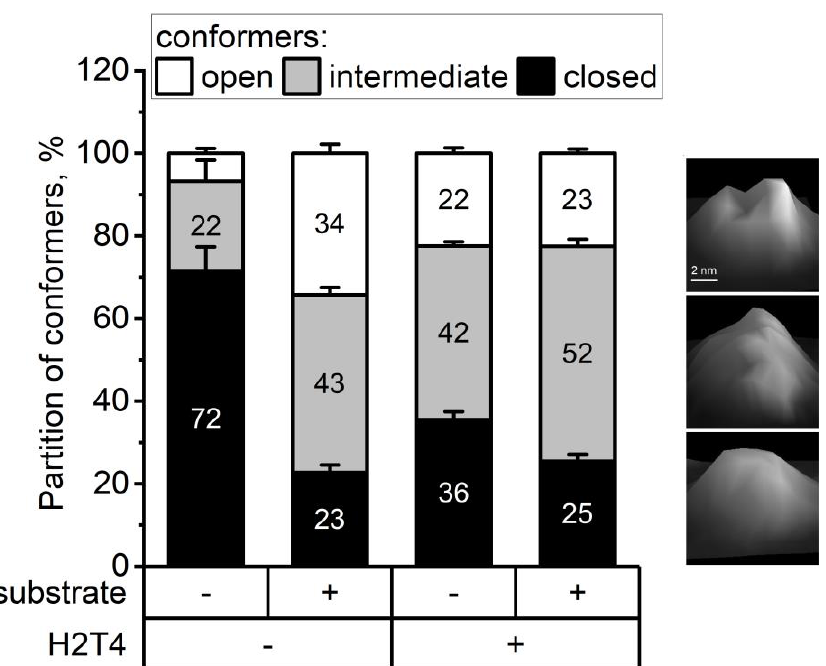
Figure 6. Partition of conformers in h20S proteasome detected with Atomic Force Microscopy Imaging (AFM). An addition of the model substrate or the porphyrin ligand shifted the conformational equilibrium toward less of the closed-gate forms and increased contribution of open and intermediate forms. However, an addition of the SucLLVY-MCA (succinyl-LeuLeuValTyr-7-amino-4-methylcoumarin) substrate to H2T4 (0.2 µM) — pretreated proteasomes did not result in the increase in open-gate forms, as would be expected for the substrate-processing 20S. Differences between the partitions of the same conformers in distinct cases (columns) were statistically significant in all pairs, with three exceptions: “open” ( p = 0.95) for the H2T4 and H2T4 + substrate pair, “closed” between the substrate and H2T4 + substrate ( p = 0.058) and “intermediate” for the control + substrate and H2T4 pair. On the right are examples of 3D projections of images of the top-view proteasomes in the three conformations, open, intermediate, closed (from the top). Averages ± SD, n = 3 to 7, with 211–354 particles per case analyzed. The numbers inside column segments represent the actual partitions (%).